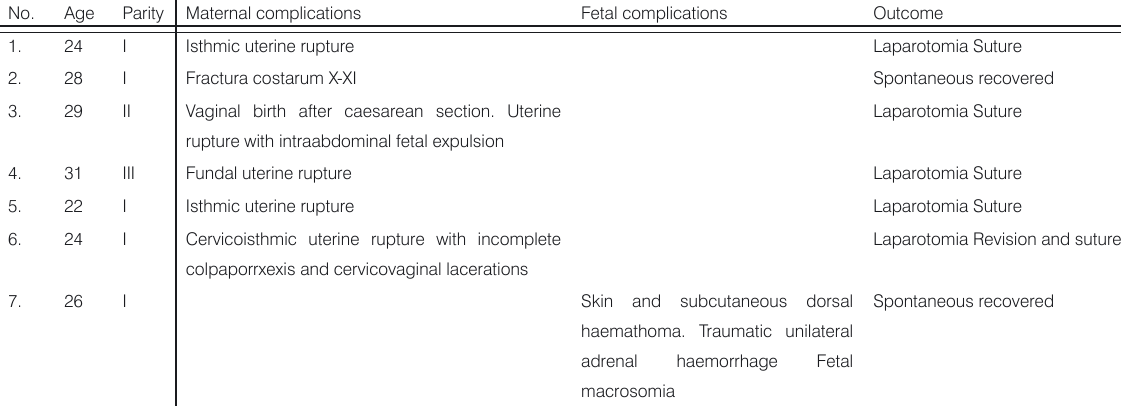
Table 1. Intrapartal maternal and fetal complications during the Kristeller's